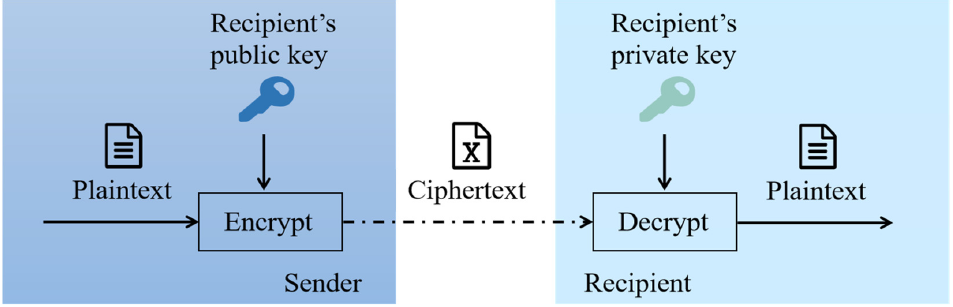
Figure 2. Asymmetric key encryption process.